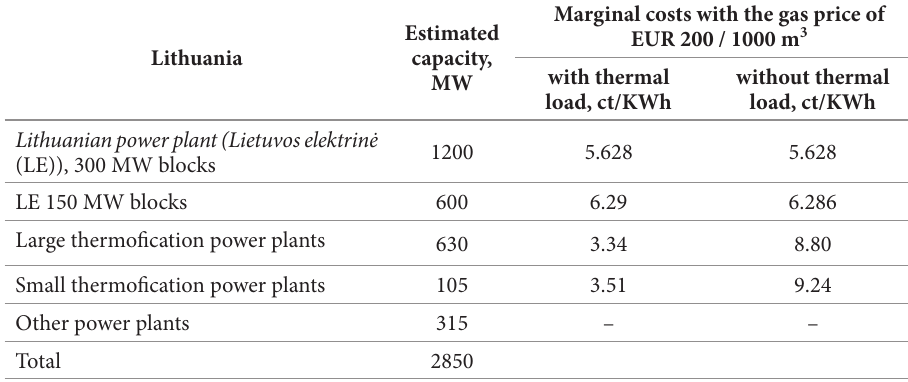
Table 1 . The installed capacity and marginal costs of Lithuania’s electricity producers Lithuania